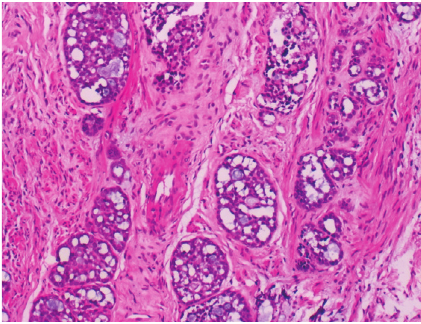
Figure 2: Photomicrograph of biopsy specimen of Case 1, showing the adenoid cystic carcinoma component, cribriform pattern (HE × 400).